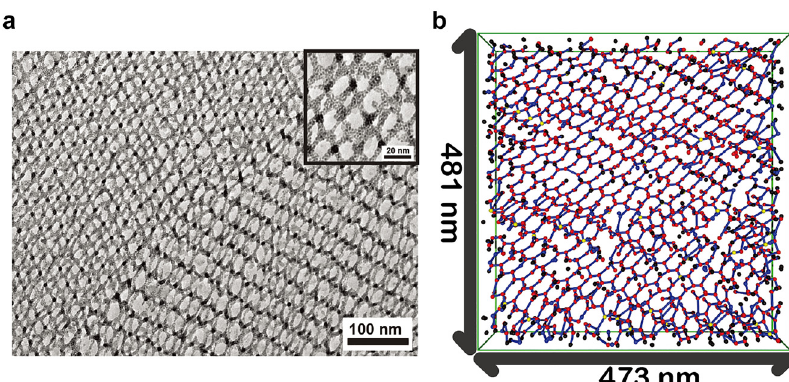
Figure 16: Single gyroid materials prepared by BCP/Nanoparticle co-assembly. (a) Transmission electron microscopy (TEM) image of Pt nanoparticles directed by BCP-derived gyroid structure. (b)